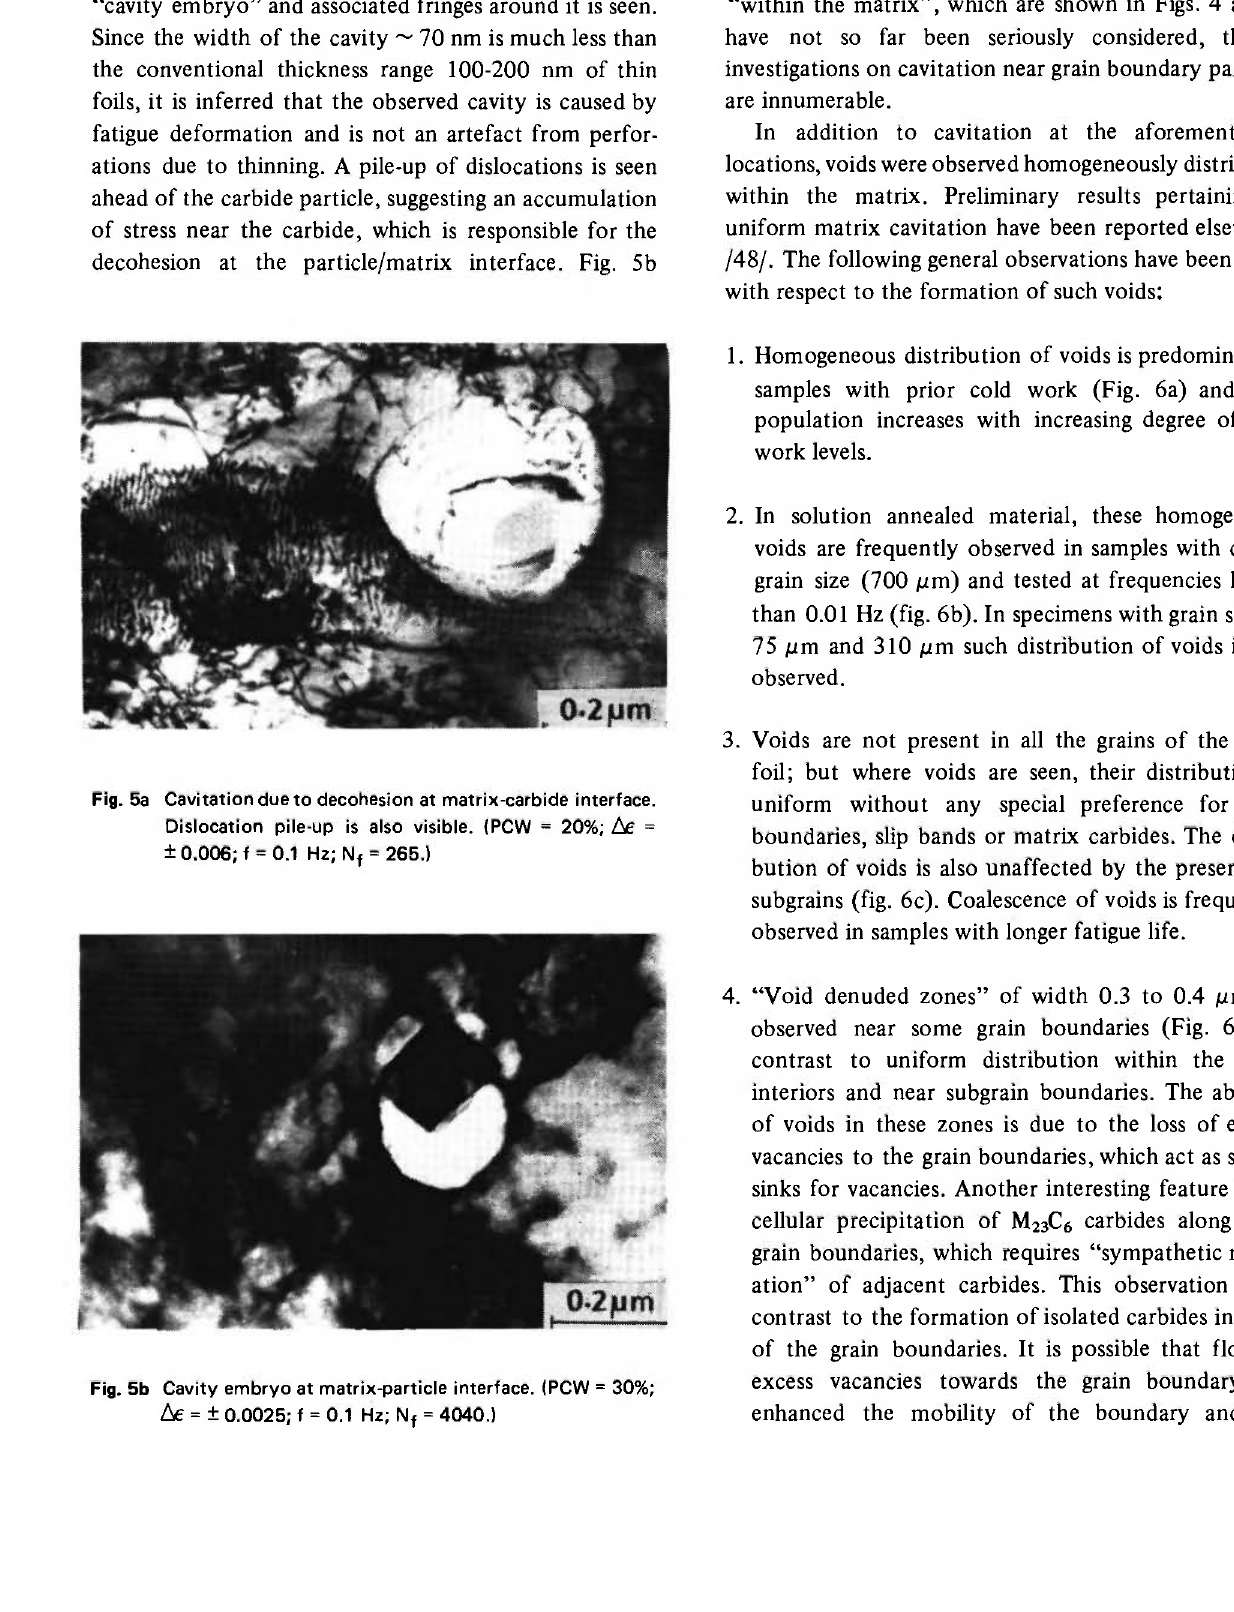
Fig. 5b Cavity embryo at matrix-particle interface. (PCW = 30%; Δε = ± 0.0025; f = 0.1 Hz; N f =